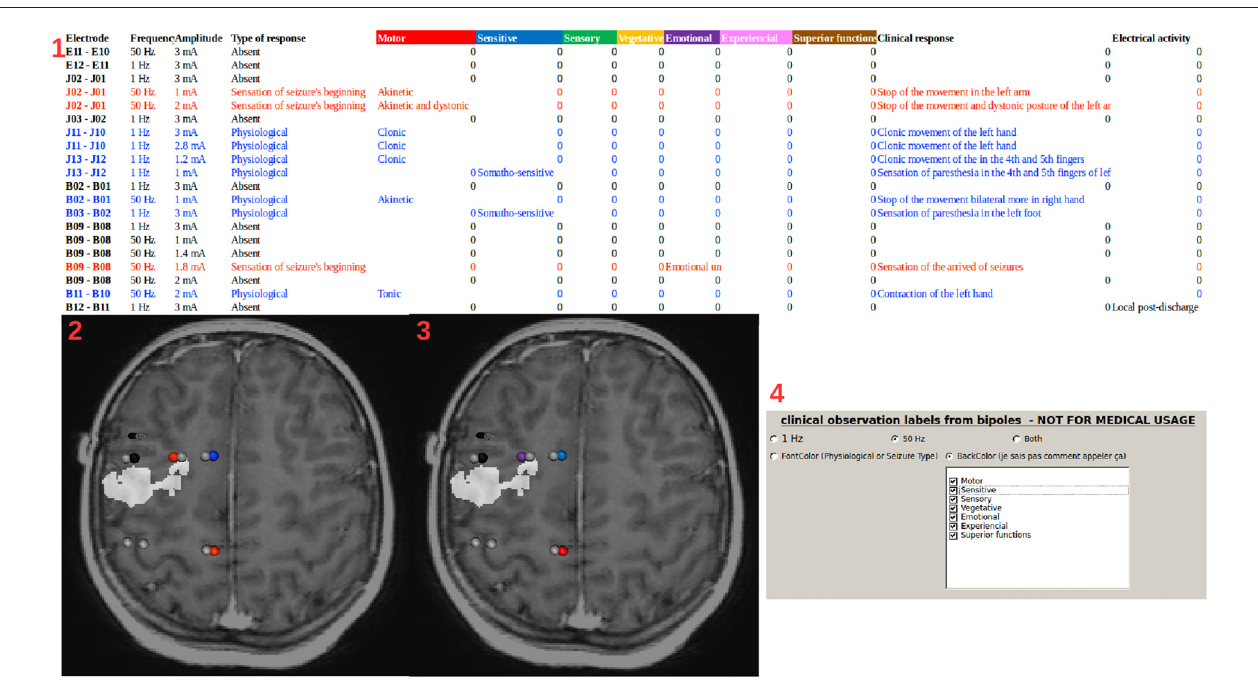
FIGURE 7 | Stimulation labels. (1) Example of a table file (first line and column generated by IntrAnat) filled manually during the stimulation sessions. The file is then read by IntrAnat and integrated into the database. Information can be displayed by LocateElectrodes as in (2) and (3) using the pre-implantation T1 fused with the resection mask (in white) as a background. Using the GUI (4), one can select the information that is displayed (in the case of cortical stimulation here, 1 Hz stimulation, 50 Hz stimulation or both). The font color of the table file is used to set the colormap: non-stimulated contacts in gray, stimulated contacts with no clinical observation in black, stimulated contacts where the patient had a response but without a link to epilepsy in blue, stimulated contacts where the patient had a response similar to the beginning of a seizure in red (2). Alternatively, one can display the classification of the response (using the background color of the line 1 of the table file): motor in red, sensitive in blue, sensory in green, vegetative in yellow, emotional in purple, experiential in pink and superior function in brown (3). The GUI (4) allows to display all or part of these classifications. Contacts not recorded in the SEEG file are not represented.